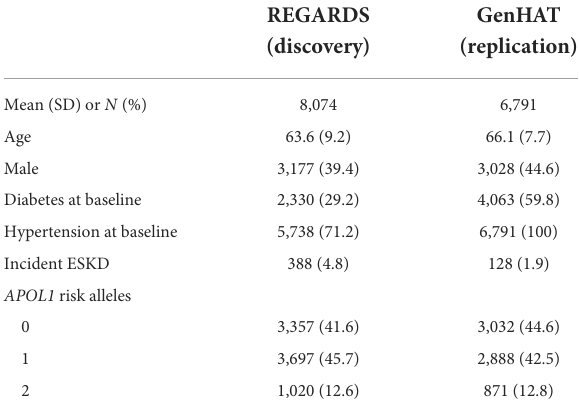
TABLE 1 Baseline characteristics of discovery and replication